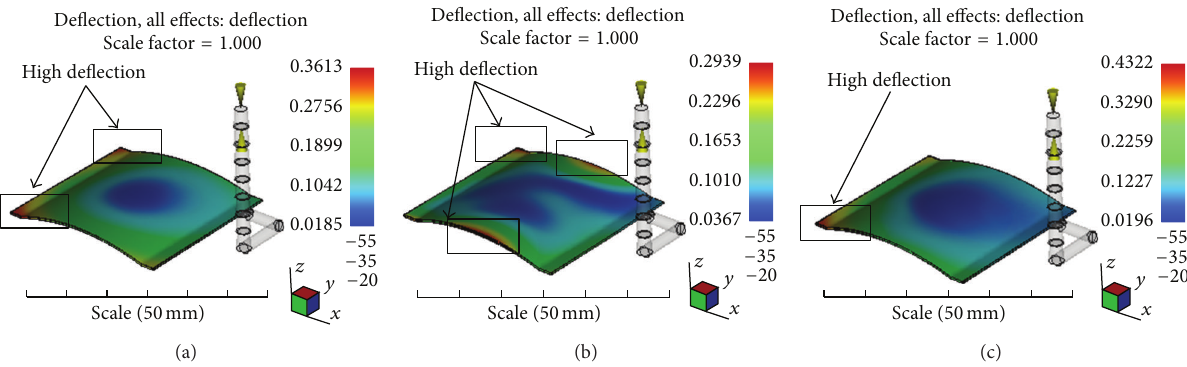
Figure 7: The distribution of warpages on the thin-walled parts for (a) PP, (b) PP + 10wt% glass fibre, and (c) PP + 50 wt% wood.